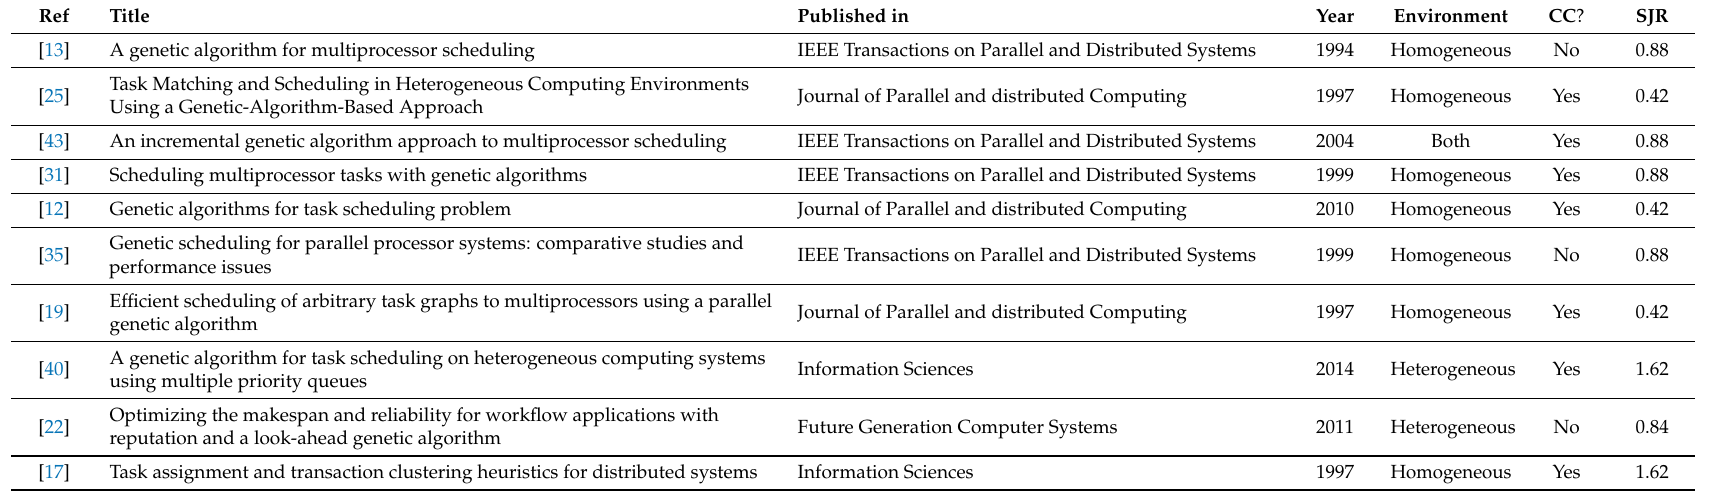
Table 7. Characteristics of the ten most cited